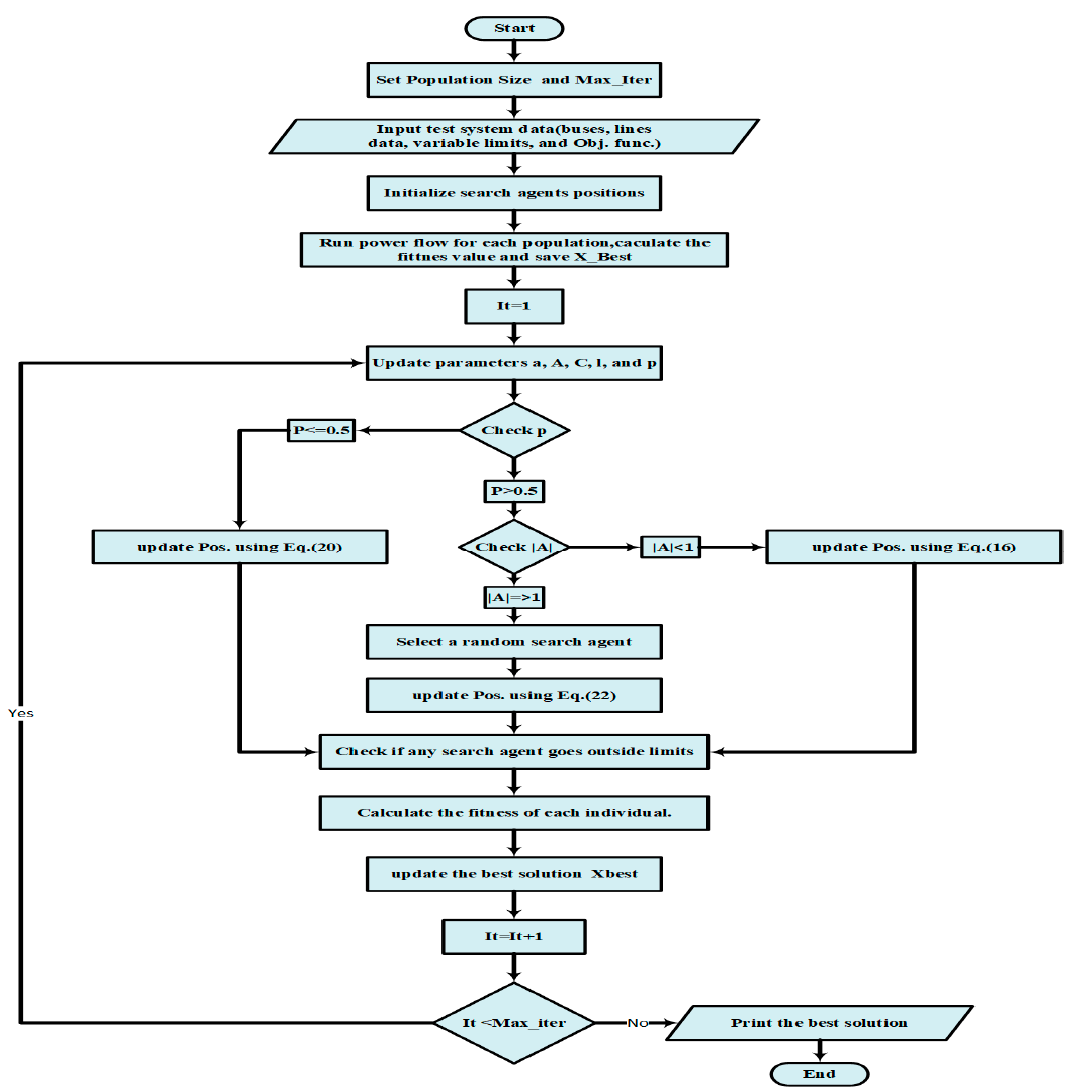
Figure 3. The implementation process of the WOA for the OPF problem.